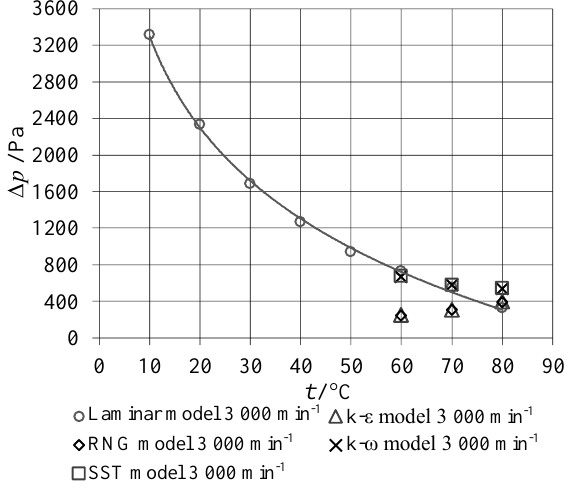
Fig. 10. Dependence of the pressure drop ∆p on the oil temperature t and the pump revolutions n p = 3 000 min -1 for the laminar and turbulent models The dependencies ∆p = f(t) determined by turbulent SST and k - ω models approximate with their trends to the dependence ∆p = f(t) determined by the laminar